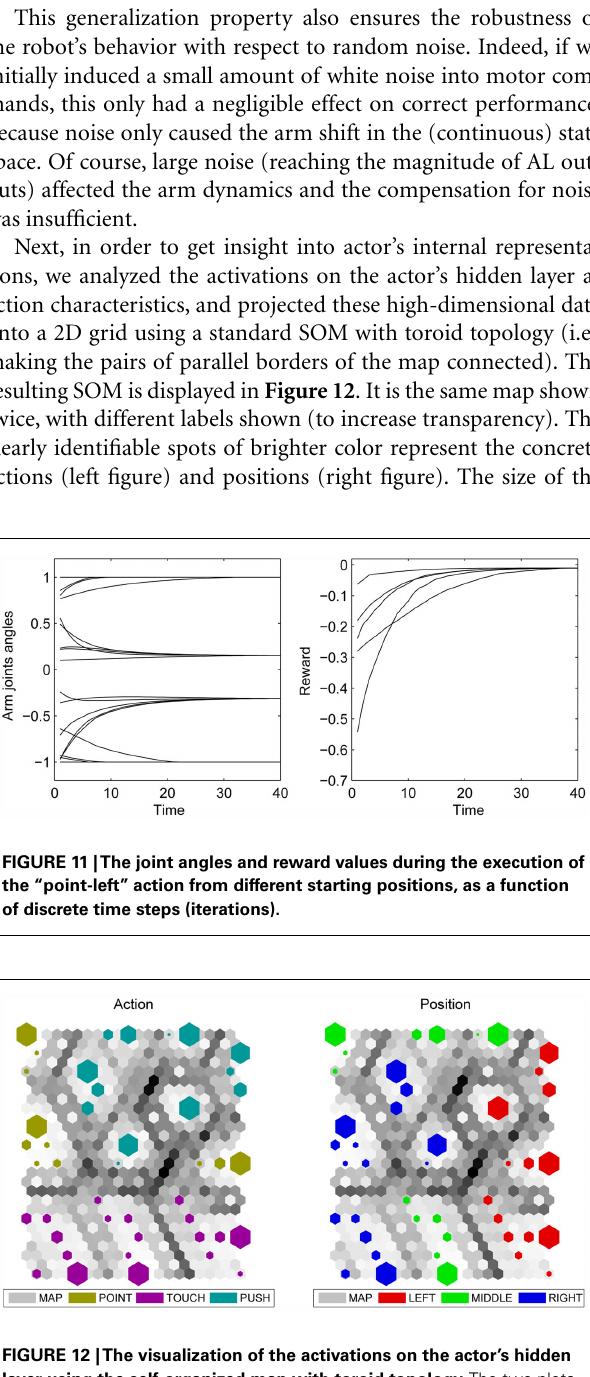
FIGURE 10 | Reward obtained during the execution of learned actions, as a function of discrete time steps.